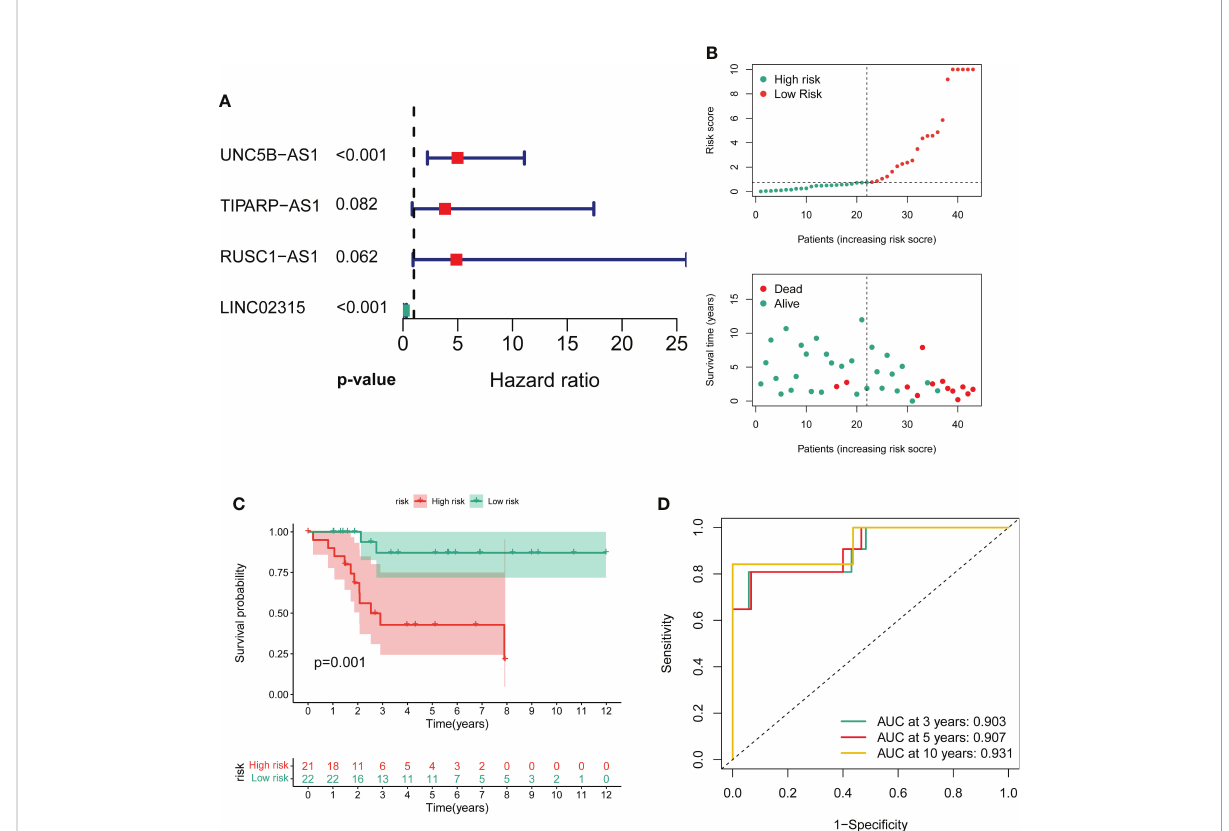
FIGURE 2 Construction of the novel CRL signature. (A) Forest plot of multivariate cox regression analysis for prognostic genes. (B) The distribution of the risk scores and the distributions of overall survival status and risk score in the training groups. (C) Kaplan – Meier analysis of the overall survival between the two distinct risk groups. (D) ROC curves to predict the sensitivity and speci fi city of 3-, 5-, and 10-year survival according to the novel cuproptosis-related